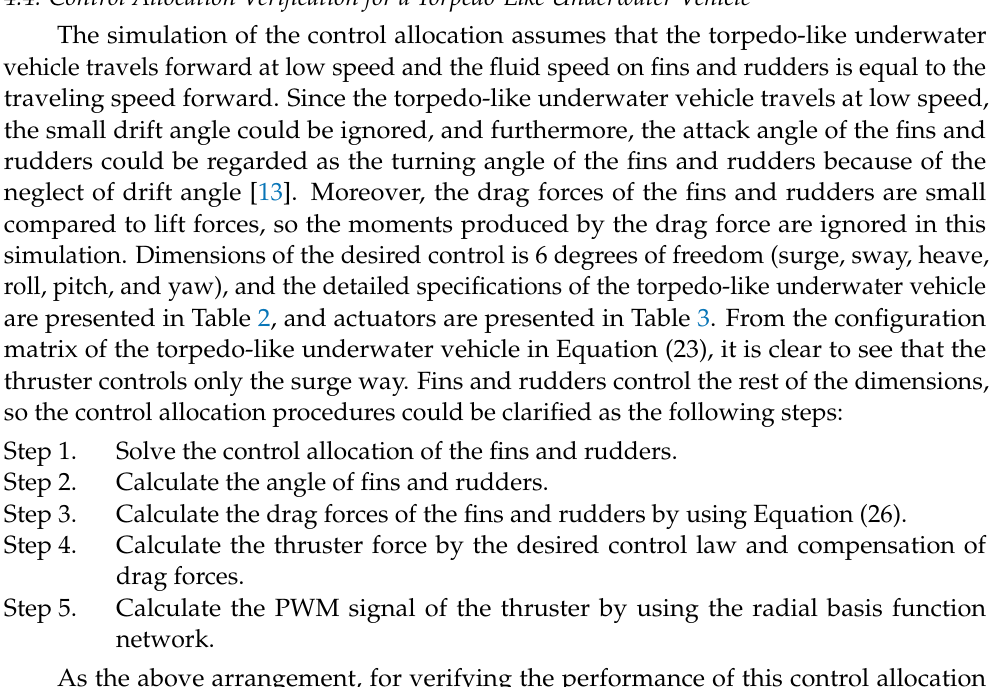
Table 4. Waypoints for Scenario 1.